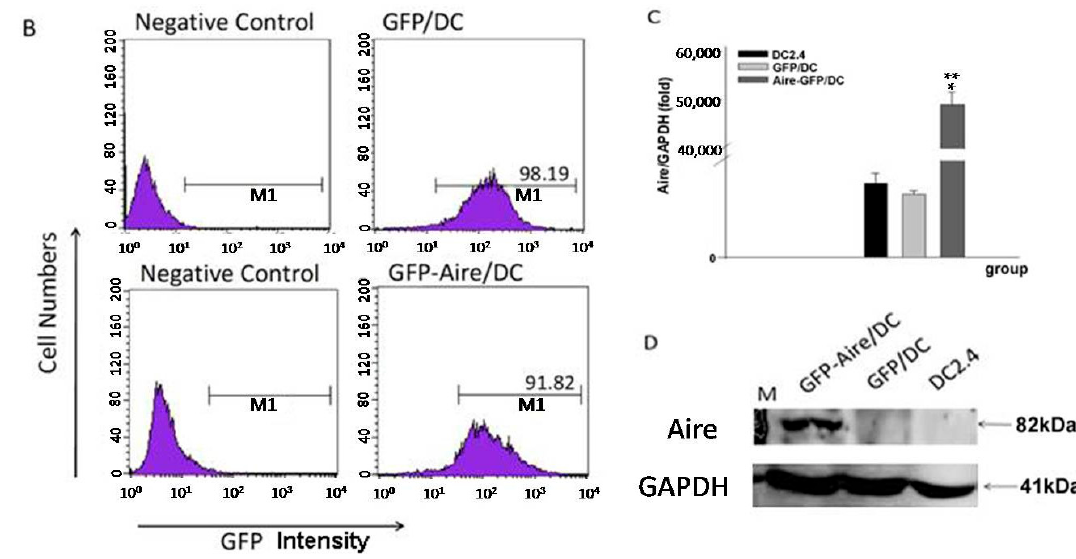
Figure 1. Identification of stable Aire-expressing transfectants. ( A ) Observation of stably-transfected cells. DC2.4 cells were transfected with pEGFPC1/Aire or pEGFPC1 expression vectors and selected with G418 as previously described. G418-selected cells were observed via fluorescence microscopy (GFP positive cells are shown as green dots). Nuclei were detected by DAPI staining (blue). Original magnification, 400×; ( B ) The transfection efficiency was assessed via FCM (the GFP positive cells were gated with M1); and ( C , D ) The Aire mRNA and protein expression levels were determined by real-time PCR and Western blotting analyses. * p < 0.01 vs. DC2.4; ** p < 0.01 vs. GFP/DC.